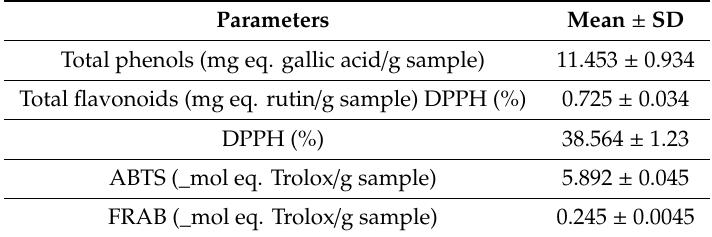
Table 1. Experimental determinations of total phenolic and flavonoids contents and antioxidant capacity assays (ABTS, DPPH, and FRAB) for G. mangostana